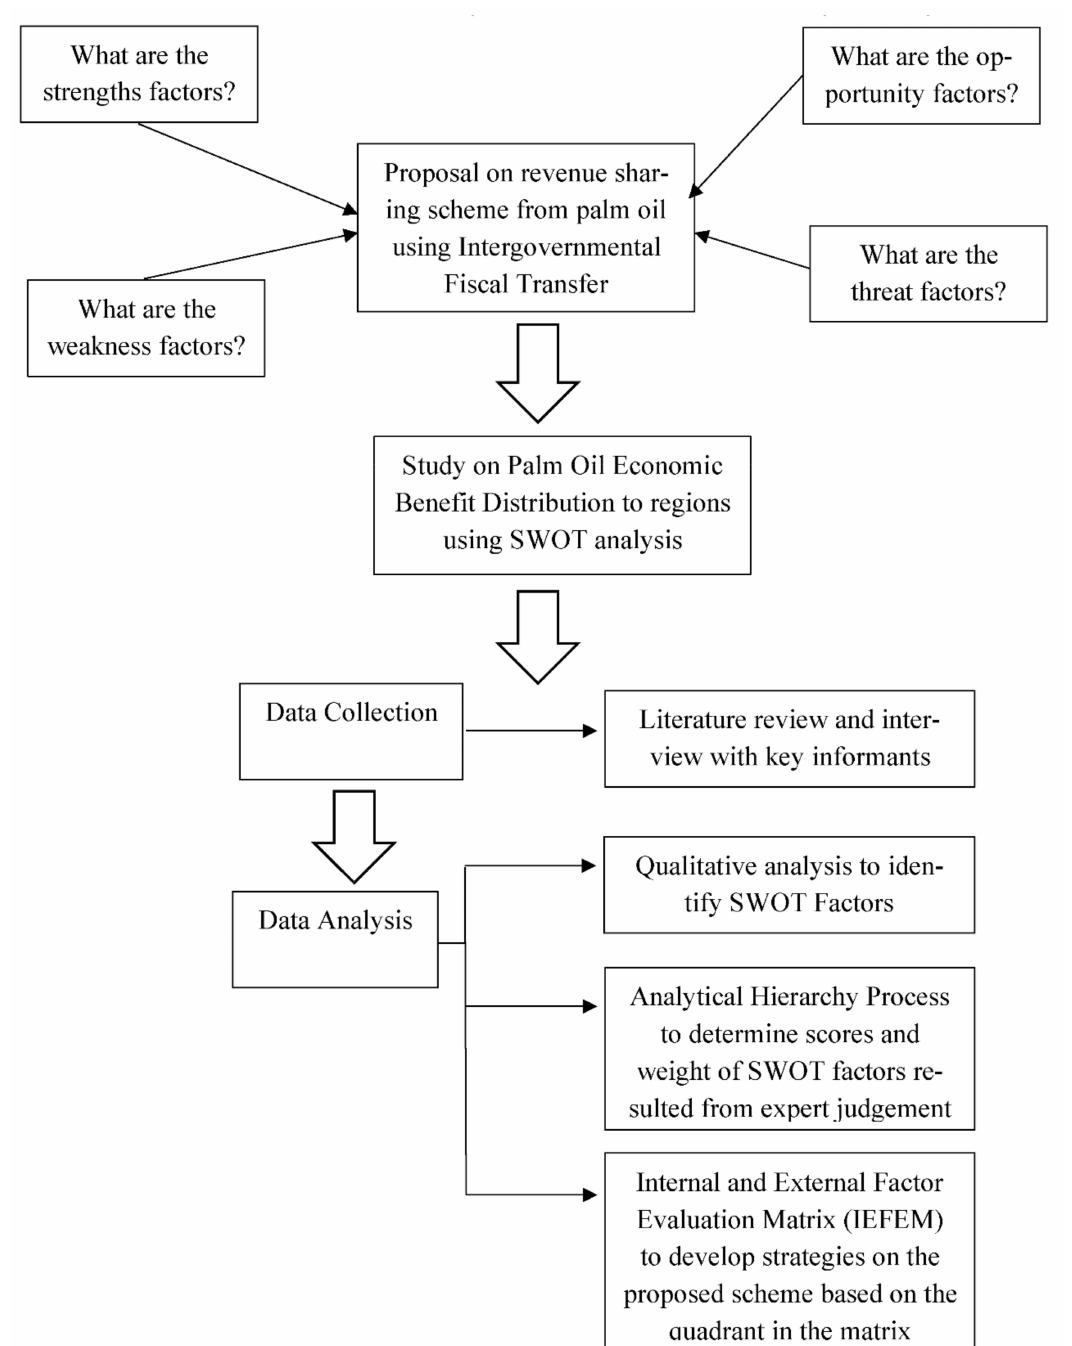
Figure 1. Research methodology